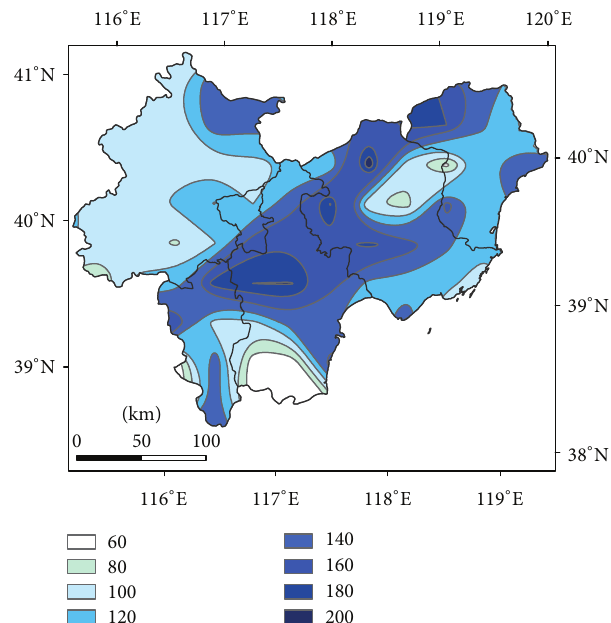
Figure 4: Projected summer precipitation difference of monthly average precipitation between control test and sensitivity test in Beijing-Tianjin-Tangshan Metropolitan area,